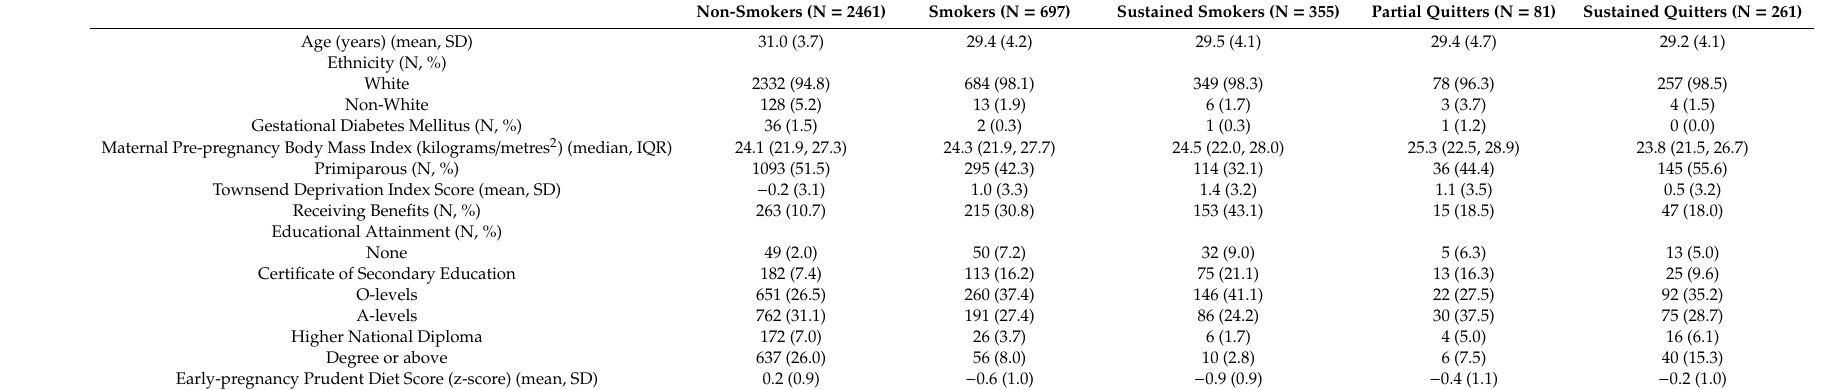
Table 1. Maternal demographic characteristics according to maternal smoking status (total N = 3158). Results expressed as mean (standard deviation), median (interquartile range), number (percentage (%)) as appropriate.